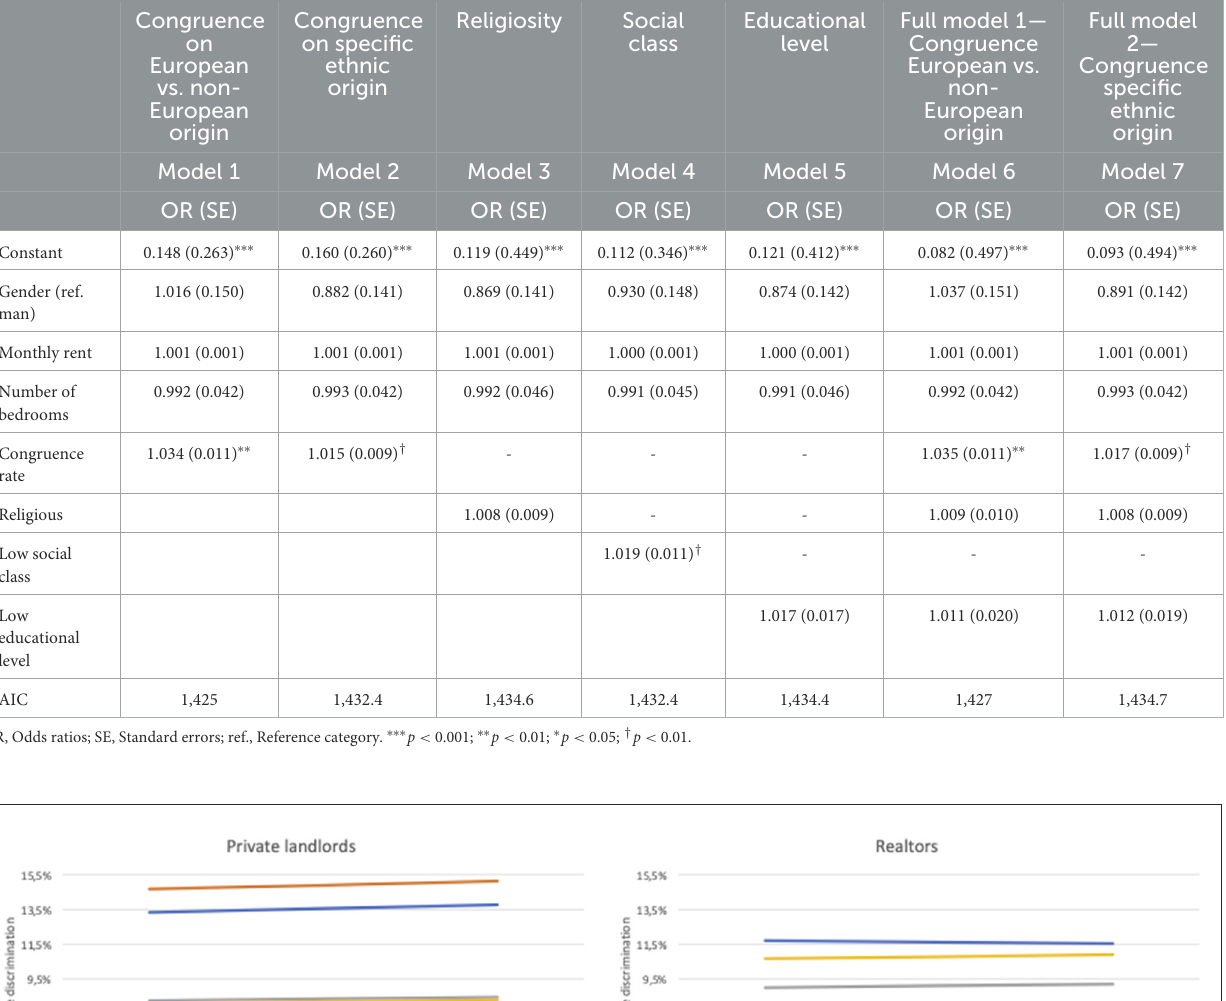
TABLE 6 Binary logistic regression on negative discrimination by private landlords ( n = 1,961).